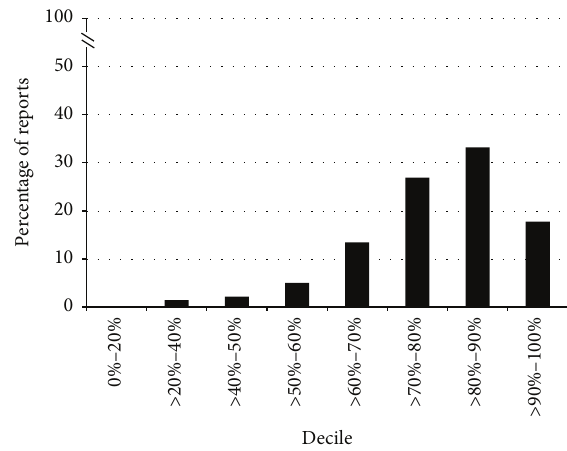
Figure 1: Distribution of the reports by decile of mandatory data elements reported, from 0 to